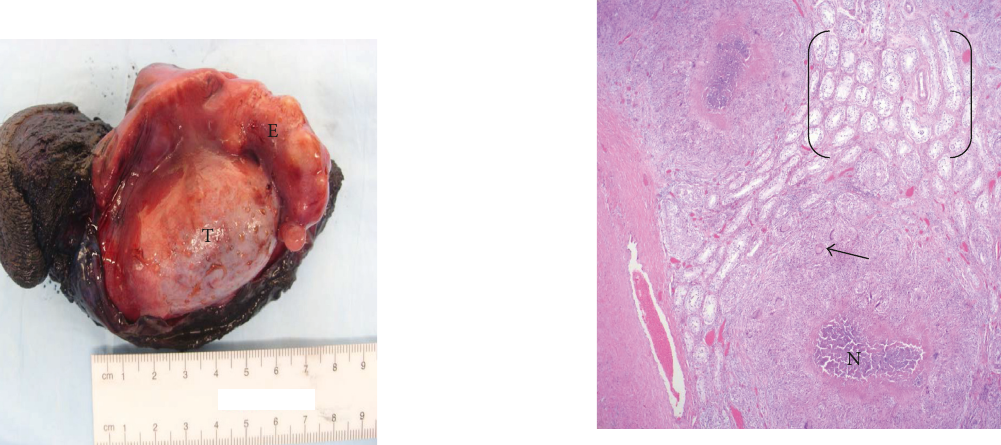
Figure 4: H&E, 4x. Necrotizing granulomatous inflammation in a miliary-type distribution, with multinucleated giant cells (his- tiocytes, arrow), central necrosis (N), and intervening, uninvolved, normal testicular tubules